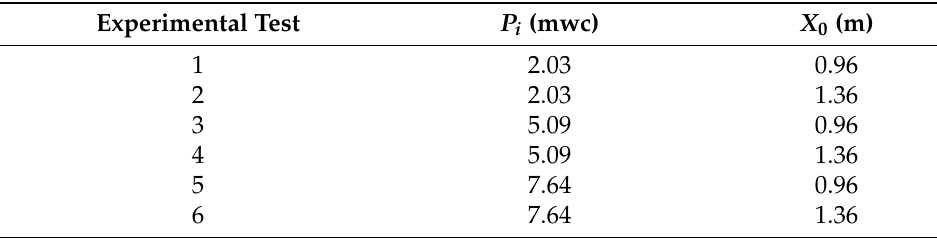
Figure 2. Conceptual scheme of the experimental facility. Table 1. Test